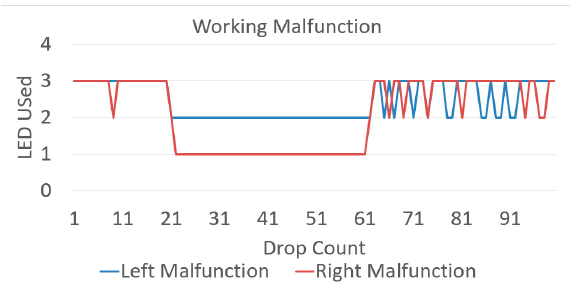
Figure 18. LED pair used during working malfunction.